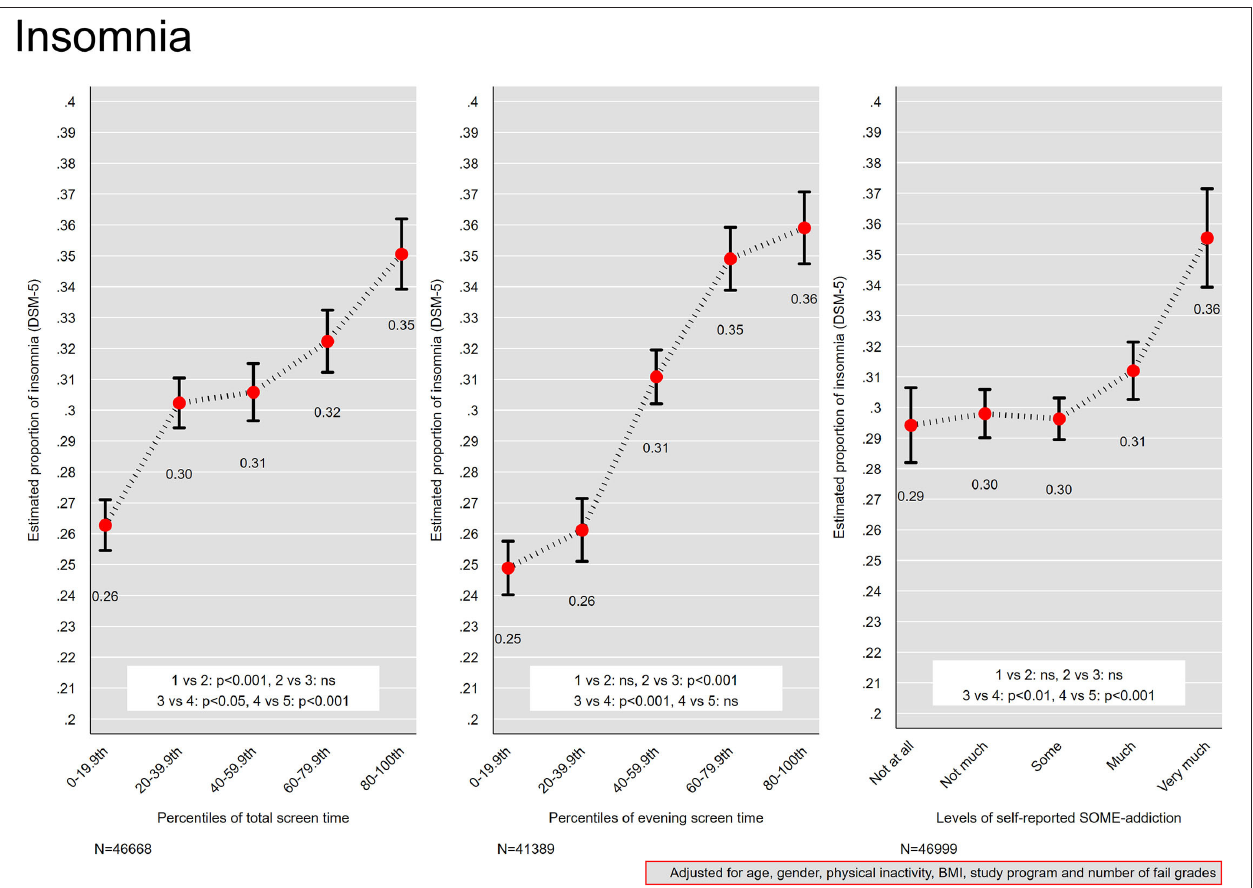
FIGURE 5 | Insomnia. Proportion of insomnia across quintiles of total screen time and evening screen time, and levels of self-reported social media addiction. Results from logistic regression models adjusted for age, gender, physical activity, and body mass index. Bars denote 95 % confidence intervals.